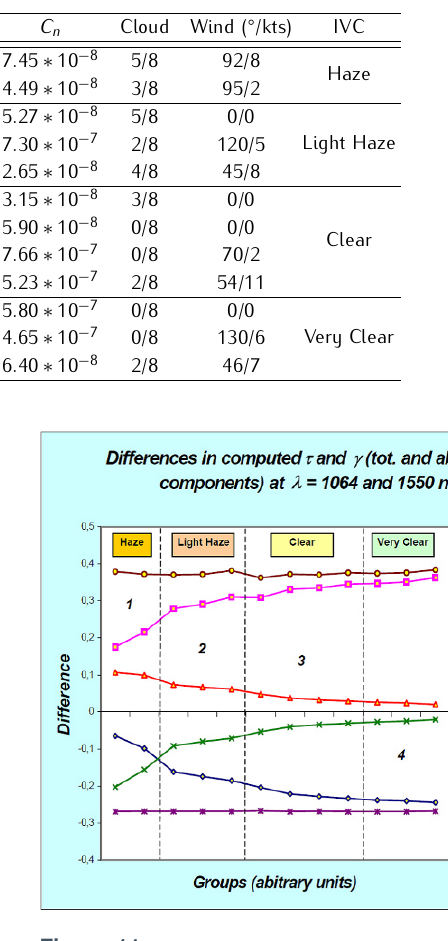
Table 15. Meteorological data for dry-air propagation measurements at λ = 1550 nm.